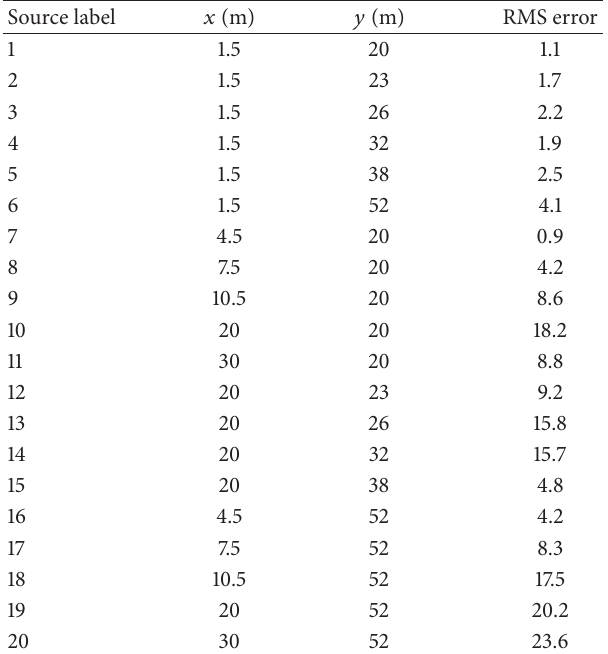
Table 2: Position referring to Figure 8 and the RMS errors of the localization estimation using SRP-PHAT